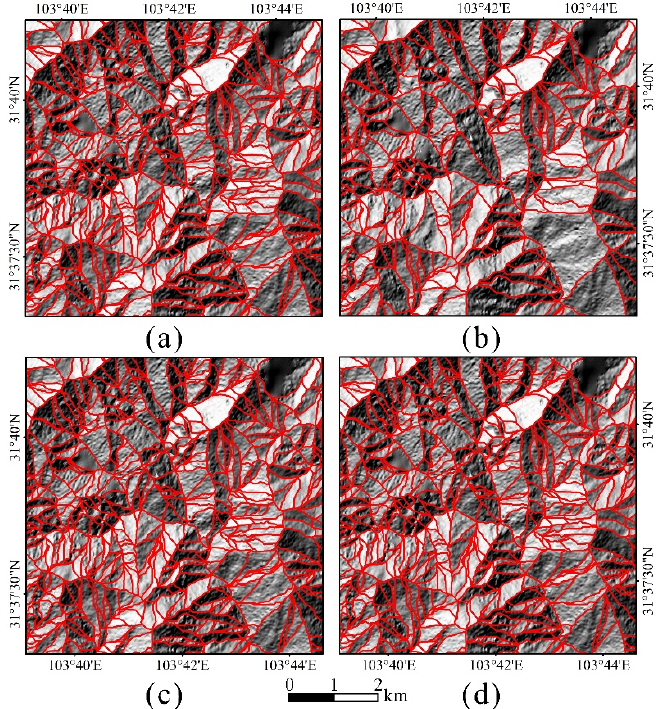
Figure 7. Slope unit partition with different combinations of a and c in the same area: a is 1 × 10 5 m 2 in ( a – d ), and c is 0.1, 0.2, 0.15 and 0.3 in ( a – d ), respectively.